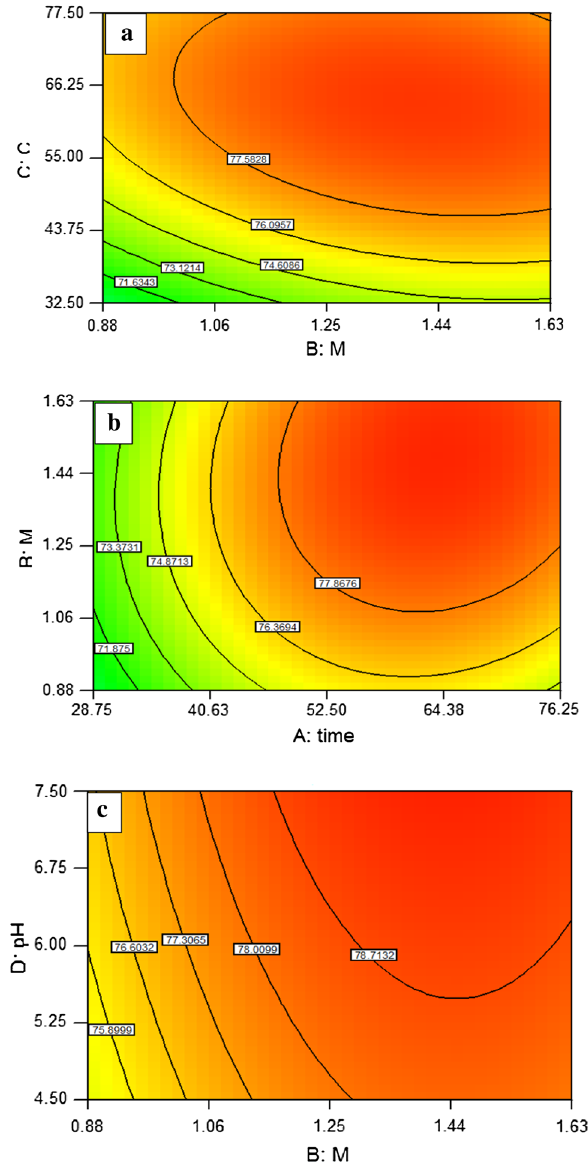
Fig. 6 2D counter plots showing the interactive effect of a adsorbent dosage and dye concentration, b contact time and adsorbent dosage, c adsorbent dosage and